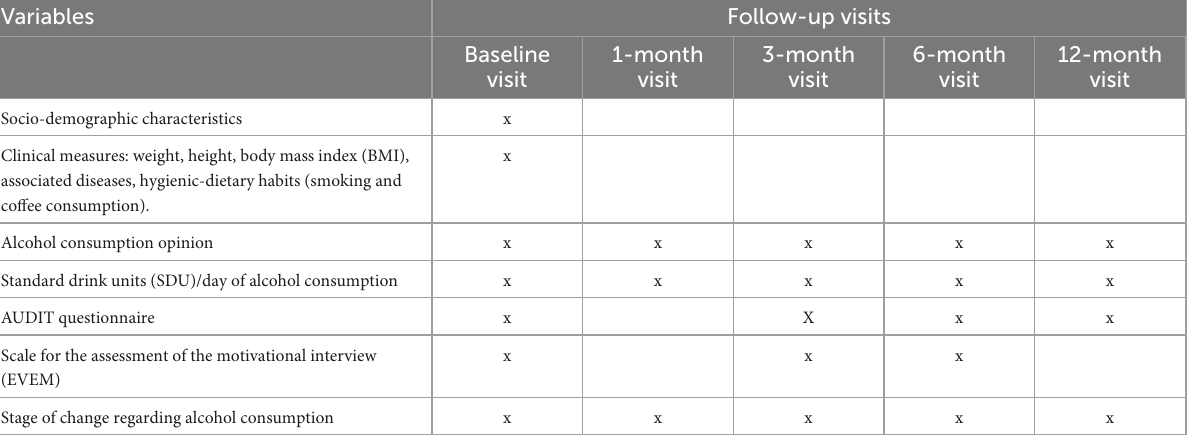
TABLE 1 Variables to be measured at each follow-up